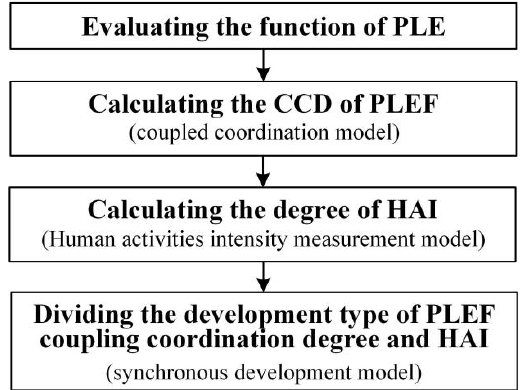
Figure 1. The primary steps of the technical solution.